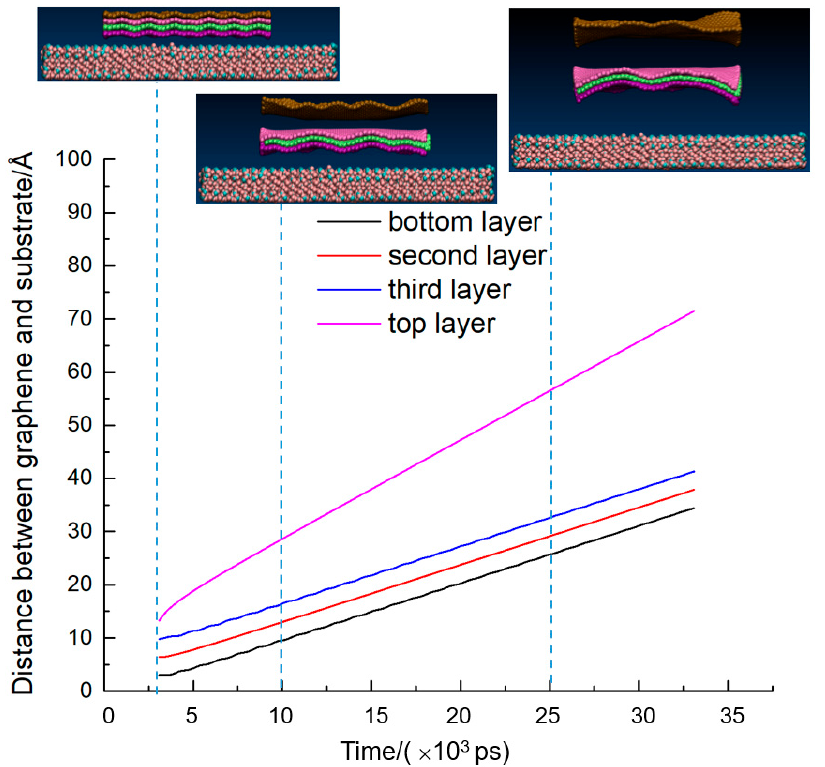
Figure 9. Exfoliation process in four-layer graphene system, when the vertical upward velocity was 10.23 Å/ps (the second critical velocity). The dotted blue line shows the trajectory at different points in time.